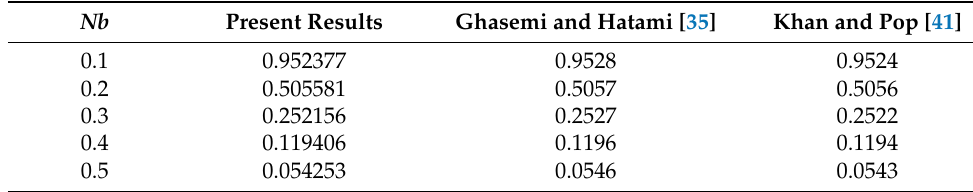
Table 1. Comparison data for the values of Nu x Re − 1/2 x for various values of Nb when Pr = Le = 10, Nt = 0.1, and Rd =